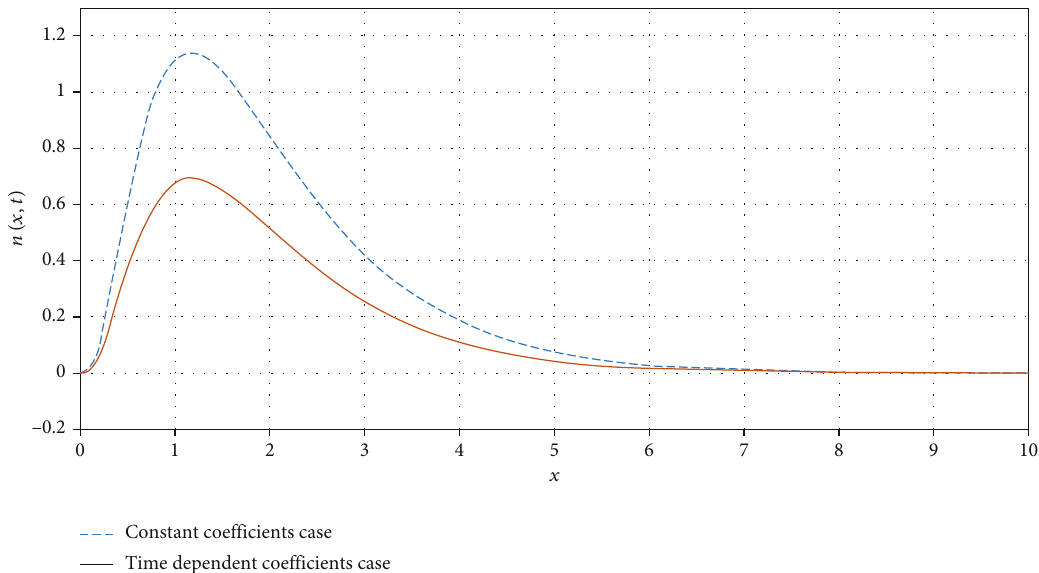
Figure 3: The SSD solution obtained by Zaidi et al. [13] for the constant coe ffi cient case and the SSD solution given by the (40) for t = 1 , α = 3 , β = 3/2 , b = 1 , and g = 2